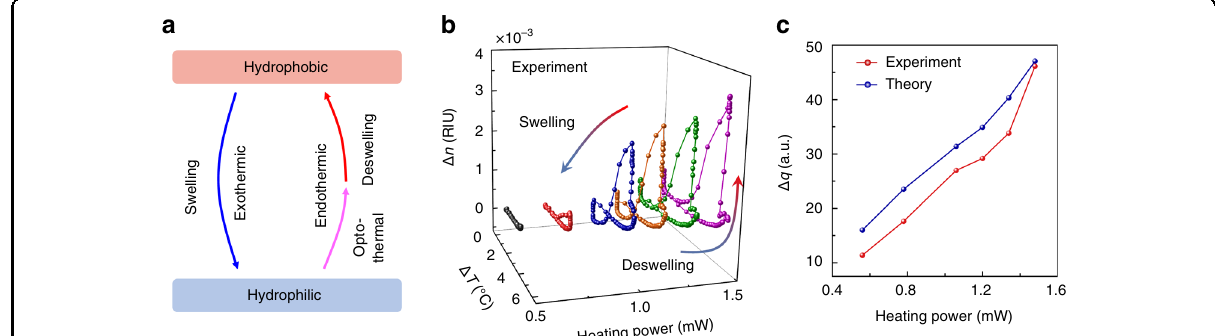
Fig. 3 Probing the phase transition dynamics of PNIPA. a Diagram of phase transition process of PNIPA. The opto-thermal effect by infrared light increases the temperature of PNIPA solution, then it activates the de-swelling transition. The hydrophobic to hydrophilic transition is a direct swelling process by ambient cooling. b Dependence of the refractive index change on the temperature of PNIPA solution at different heating power in the experiment. c Dissipated heat ( Δ q ) in a transition cycle vs. the heating power by the experimental measurement (red curve) and theoretical calculation (blue